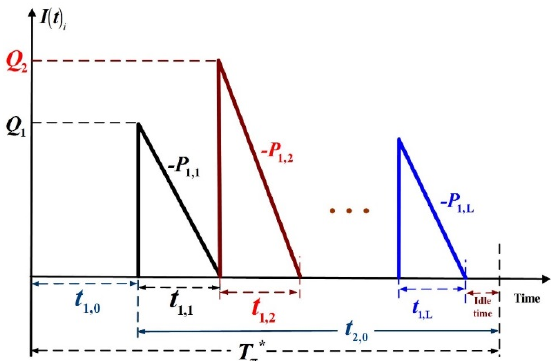
Fig. 3. The required standard components’ stock status in making each merchandise